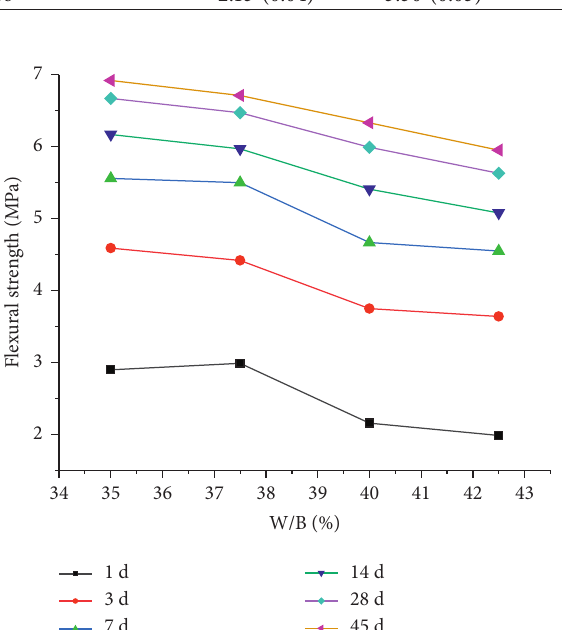
Figure 6: Influence of GGBFS content on concrete flexural strength.